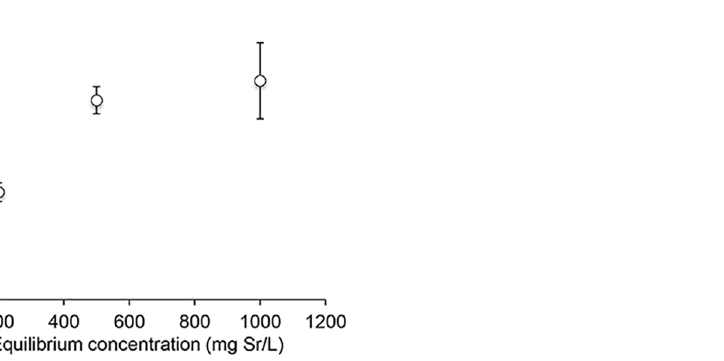
Fig 3. Langmuir model. Adsorption capacity of Chlorella to strontium. Data are expressed as the mean ± SD of three